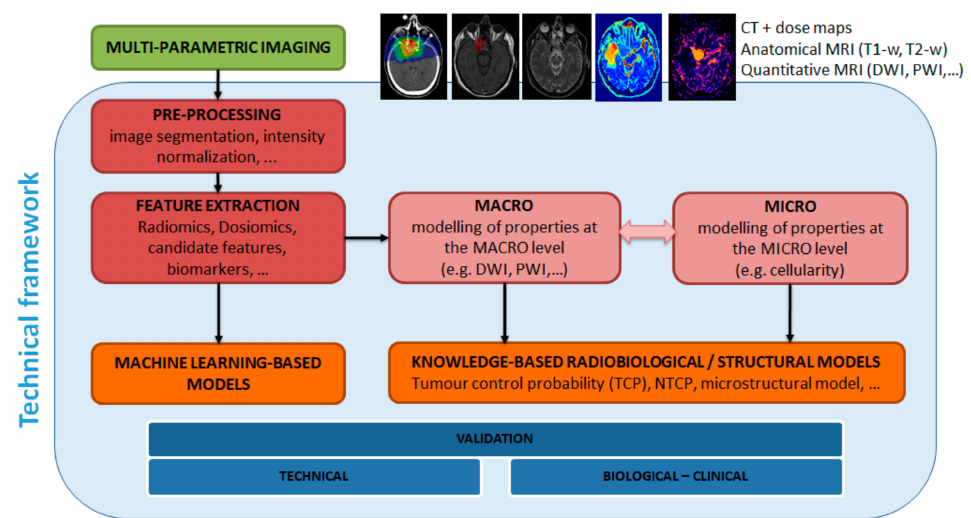
Figure 9. Studies ongoing at CNAO to integrate methodologies oriented towards a patient-specific